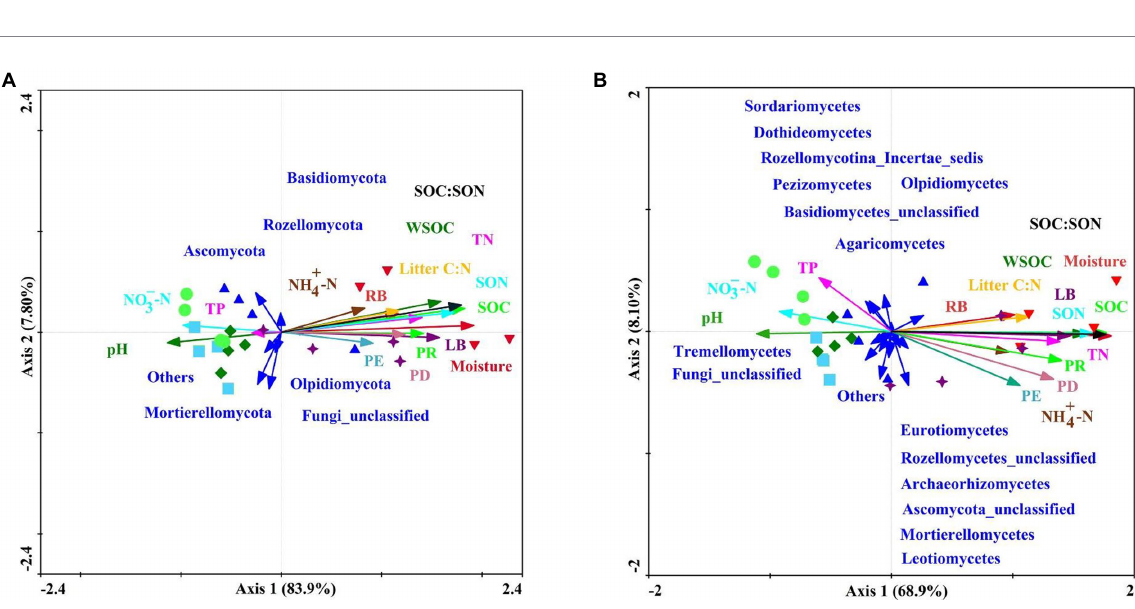
moisture, WSOC, and SOC:SON (Table 5). The relative abundance of Pathotroph was negative associated with the RB, soil moisture, SOC, and SON (Table 5). The relative abundances